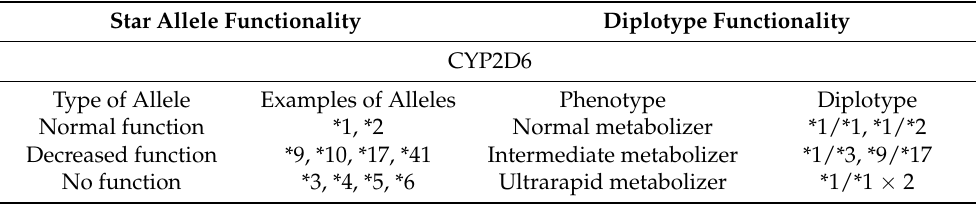
Figure 1. Illustration provides an insight into correlation between binding sites named by their unique ligands (OXV: (4-hydroxy-3,5-dimethylphenyl)(2-methyl-1-benzofuran-3-yl)methanone, GOL: glycerol, HEM: protoporphyrin ix containing Fe, HEC: heme c and SWF: s-warfarin) and genome variations (defined as dbSNP number) deposited in PDB (retrieved from Protein Data Bank) [17–20,26]. Table 1. Allele categories based on common star alleles for selected CYP enzymes (6). The data was obtained from pharmgkb.org (accessed on 5 February 2022). PharmGKB employs a framework of nine biogeographical groupings to annotate data on participants in pharmacogenomic research in terms of race and ethnicity. The study that guided the construction of the grouping system employed data from the Human Genome Diversity Project and the 1000 Genomes Project